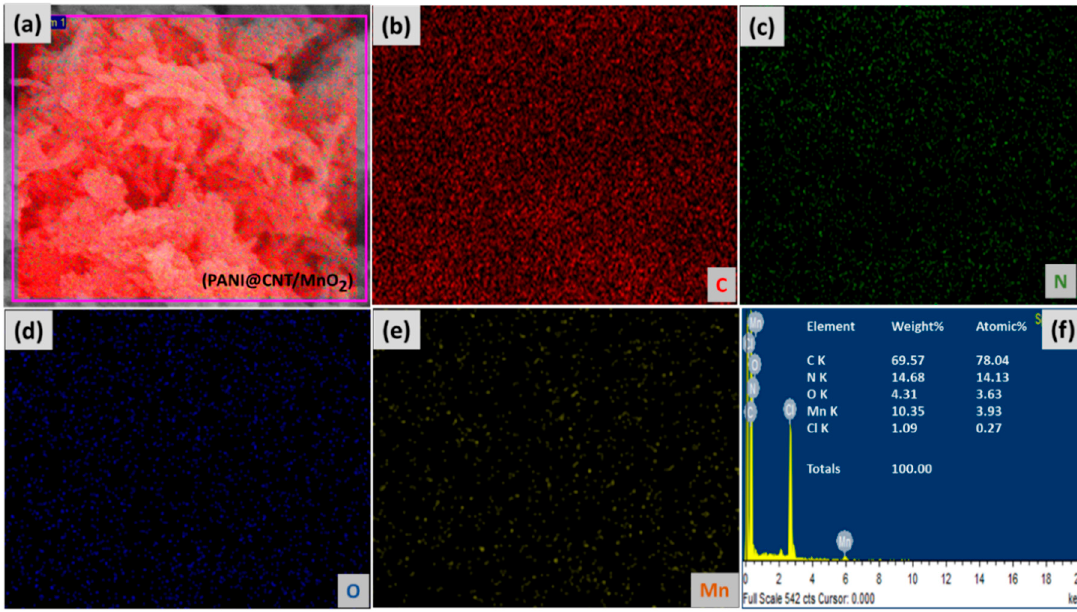
Figure 2. ( a ) Energy dispersive X-ray spectroscopy (EDS) elemental mapping of PANI@CNT / MnO 2 , ( b ) C, ( c ) N, ( d ) O, ( e ) Mn, and ( f ) compositional spectra of the PANI@CNT / MnO 2 ternary composite.